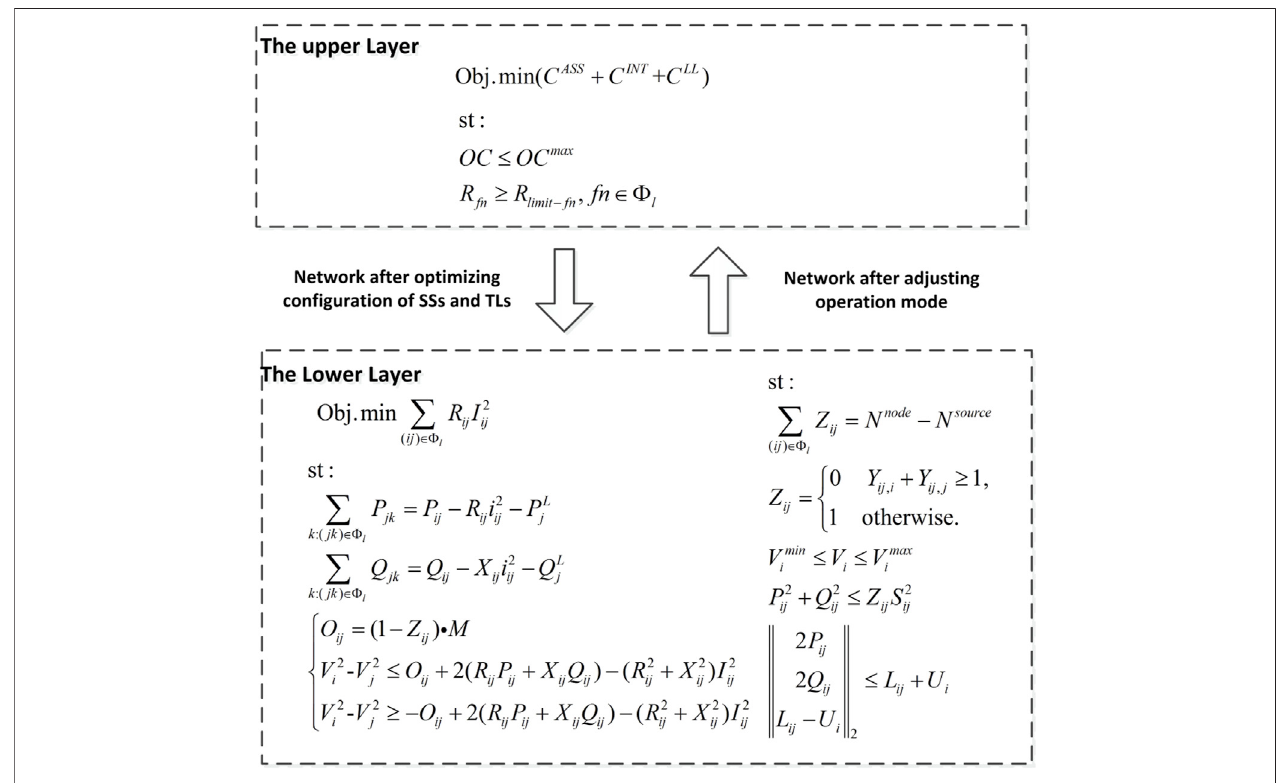
FIGURE 2 | The proposed bi-level